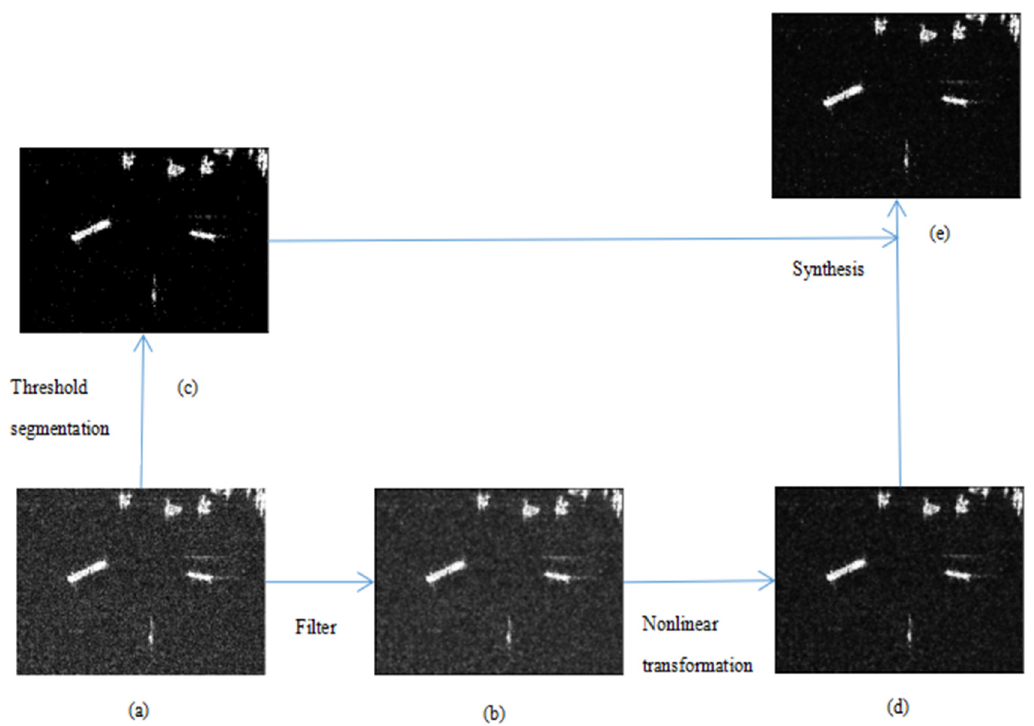
Figure 2. Image processing engineering: ( a ) original image; ( b ) Lee filtered image; ( c ) threshold segmented image; ( d ) linear transformed image; ( e ) image after fusion of d and c.